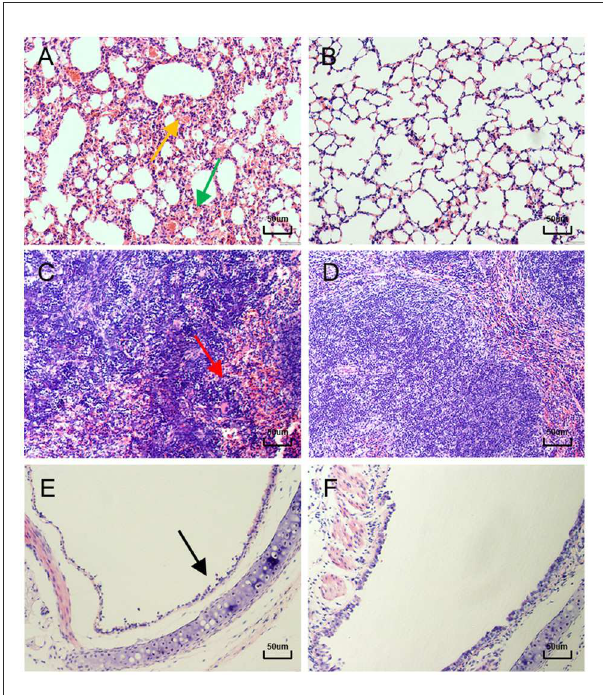
FIGURE4 Lung, Spleen and Trachea sections of mice after hematoxylin and eosin (H&E) staining. (A) 11 days after infection, the lungs of mice showed ( ) marked congestion and hemorrhage, and ( ) alveolar septal thickening ( 400 × ). (B) Normal control lung sections from mock-inoculated mice did not show observable histological changes ( 400 × ). (C) 5 days after infection, the spleens of mice showed ( ) blurred red-white medullary demarcation ( 400 × ). (D) Normal control spleen sections from mock-inoculated mice did not show observable histological changes ( 400 × ). (E) 13 days after infection, the tracheas of mice showed ( ) detached epithelial cells ( 400 × ). (F) Normal control trachea sections from mock-inoculated mice showing no observable histological changes ( 400 ×